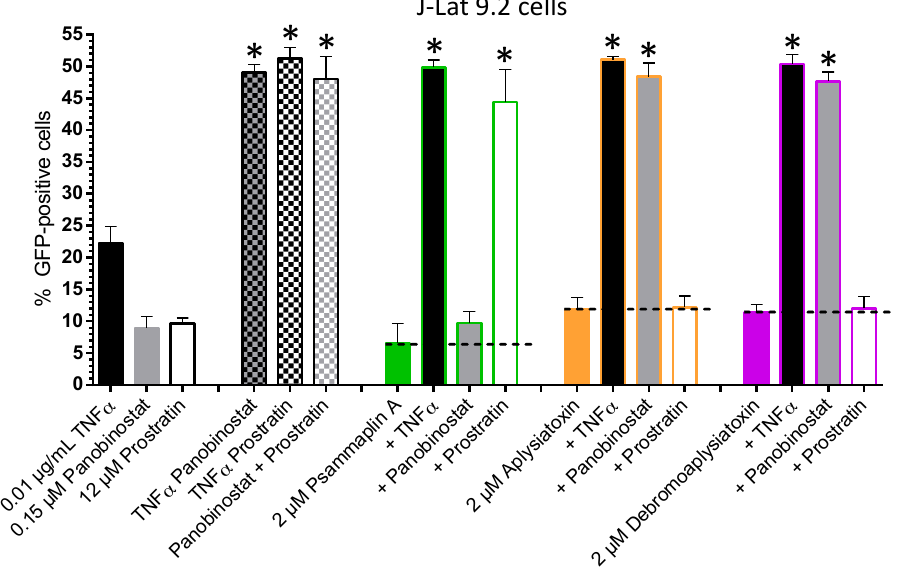
Figure 5. Effects of LRAs and LRA combinations on HIV-1 provirus expression in J-Lat cells. * p < 0.05 using the Bliss independence model [10,11].